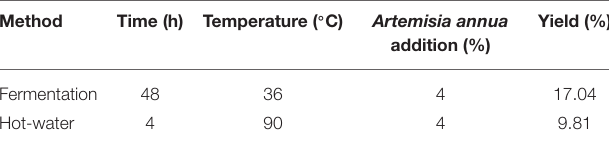
TABLE 4 | Comparison of fermentation method and hot water